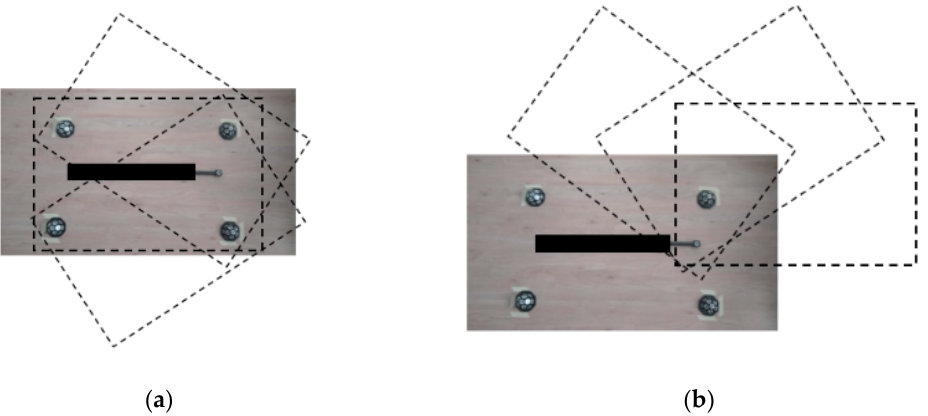
Figure 4. Relevance of the auxiliary elements: ( a ) A robust camera position can only be obtained if three or more auxiliary elements have been covered by the photographs (dashed lines). ( b ) Example of a weak camera position resolution using one auxiliary